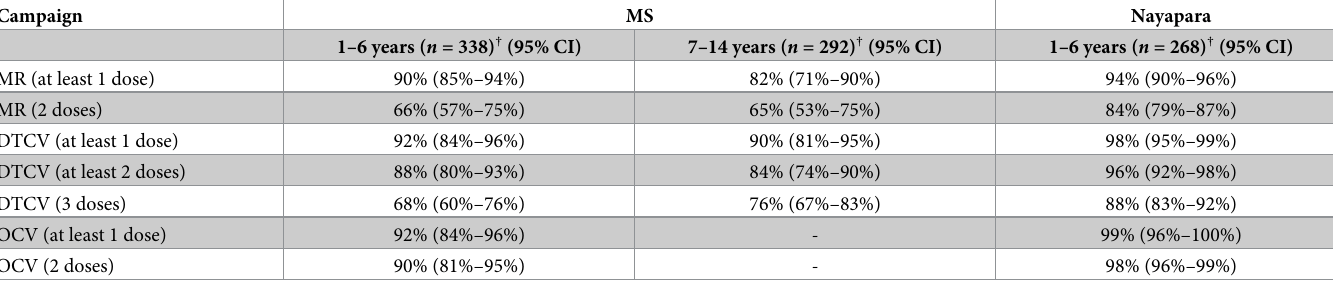
Table 3. Vaccination campaign coverage, � by geographic area and age group, serologic and vaccination coverage survey among Rohingya children, Cox’s Bazar, Bangladesh, 2018. Campaign MS